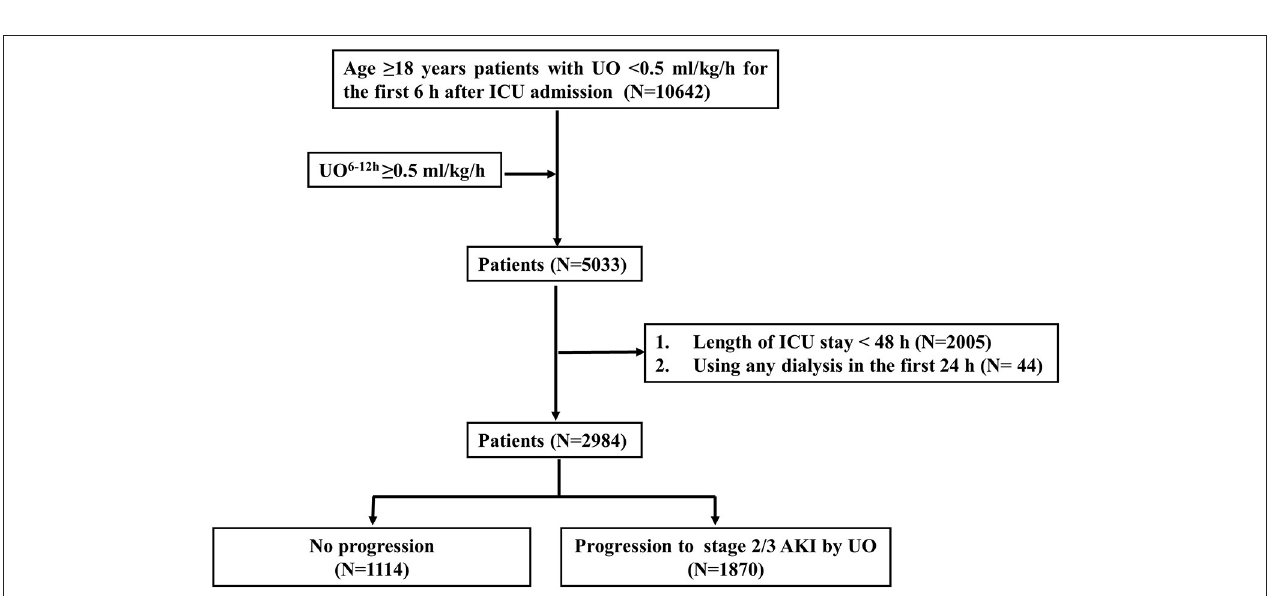
FIGURE 1 | Schematic illustration of the time windows. AKI by KDIGO UO criteria was defined as urine output < 0.5 ml/kg/h for the first 6h after ICU admission. UO, urine output; UO 6 − 12h , urine output within 6h after diagnosis of AKI by KDIGO UO criteria; ICU, intensive care unit; AKI, acute kidney injury; KDIGO, Kidney Disease: Improving Global Outcomes.